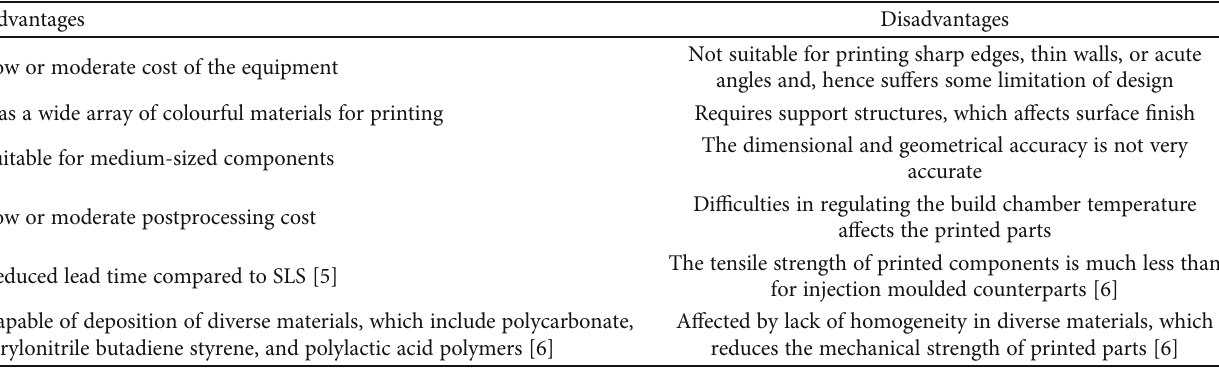
Table 2: Advantages and Disadvantages of FDM.